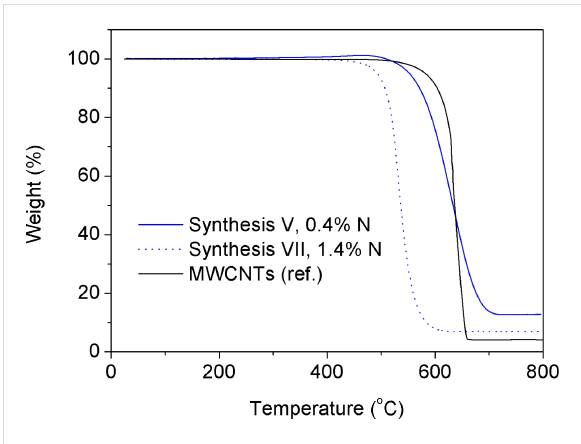
Figure 8: Overlaid TGA curves recorded in air for N-CNTs ( Synthesis V and VII ) and MWCNTs ( Ref. Synthesis ).